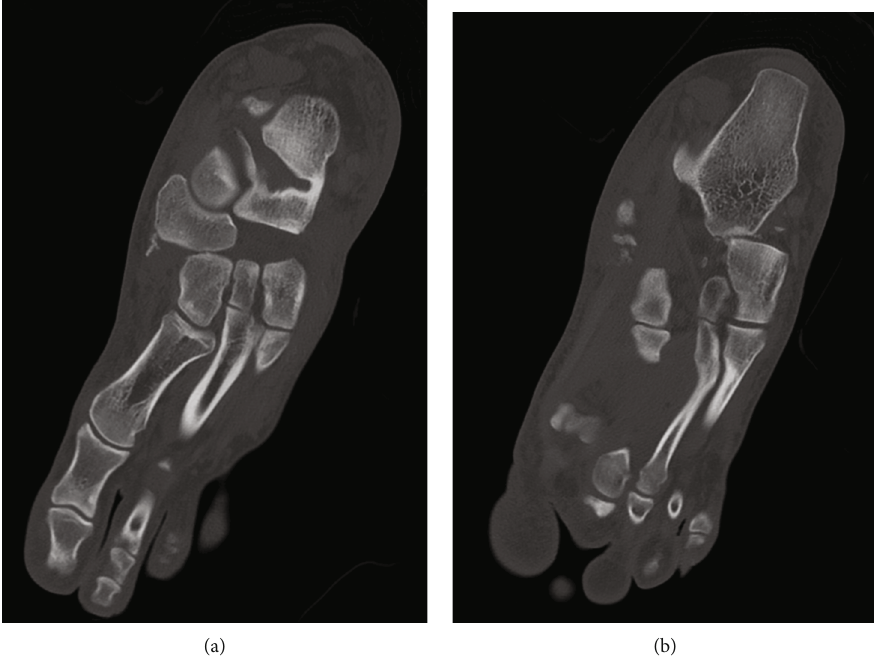
Figure 2: Oblique multiplanar reconstruction CT of the left foot shows dislocation of the (a) naviculocuneiform joint and of the (b) calcaneocuboid